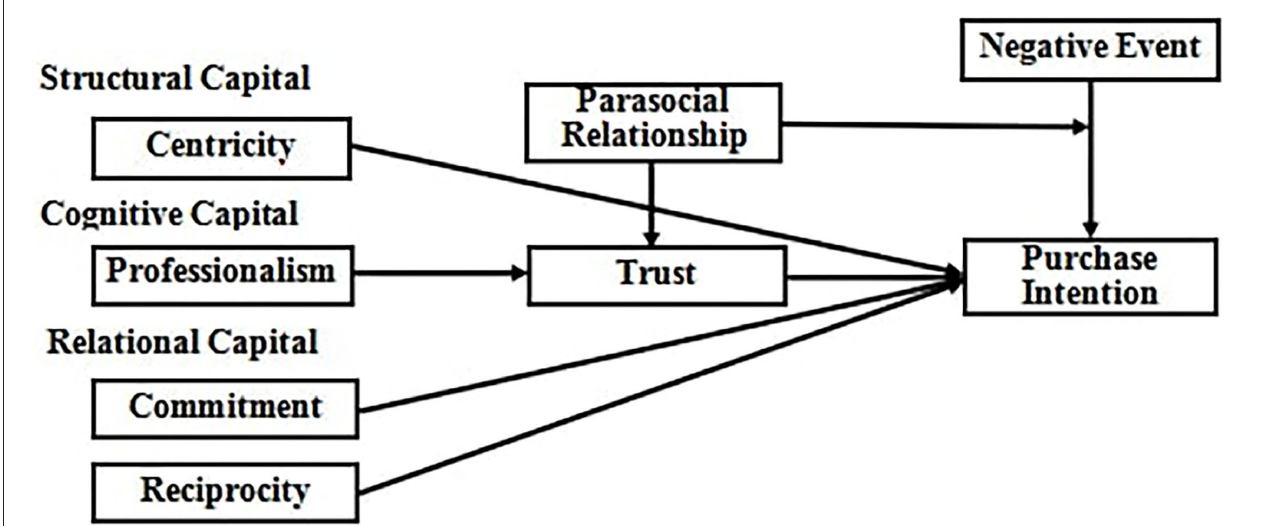
FIGURE 1 | Research